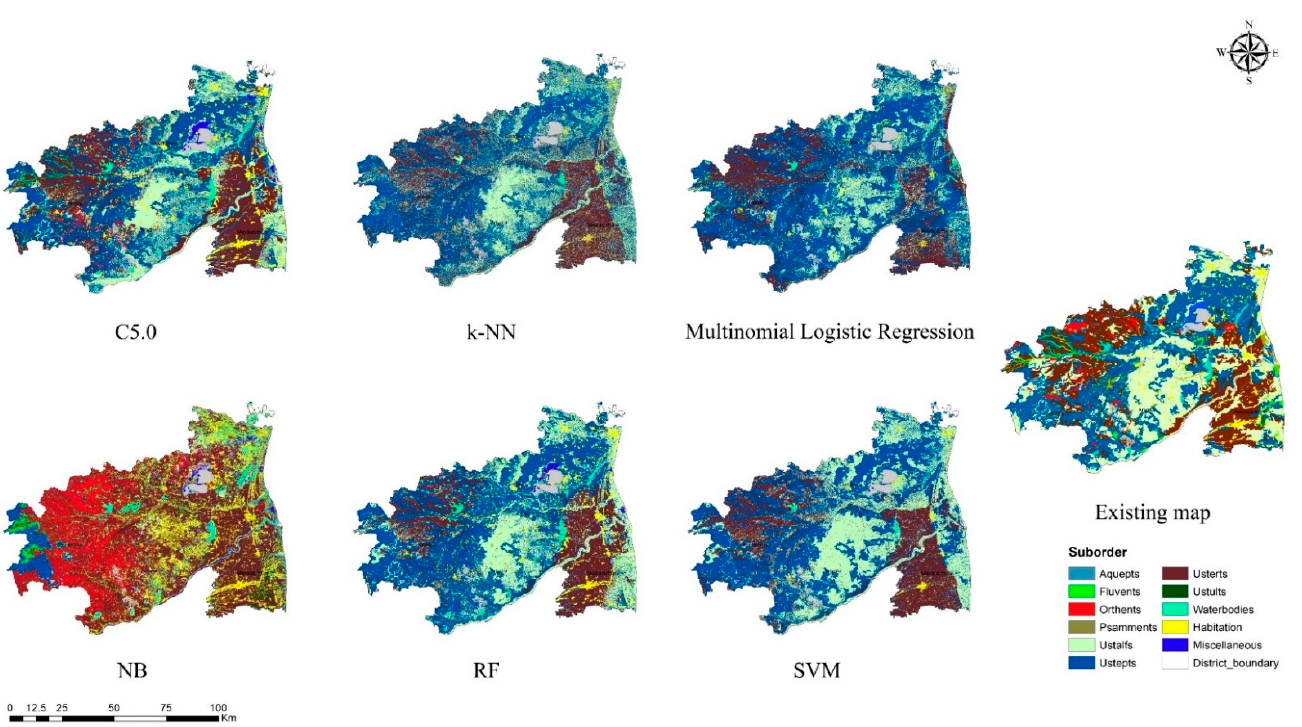
Figure 6. Existing and predicted maps of suborder using different machine learning algorithms.